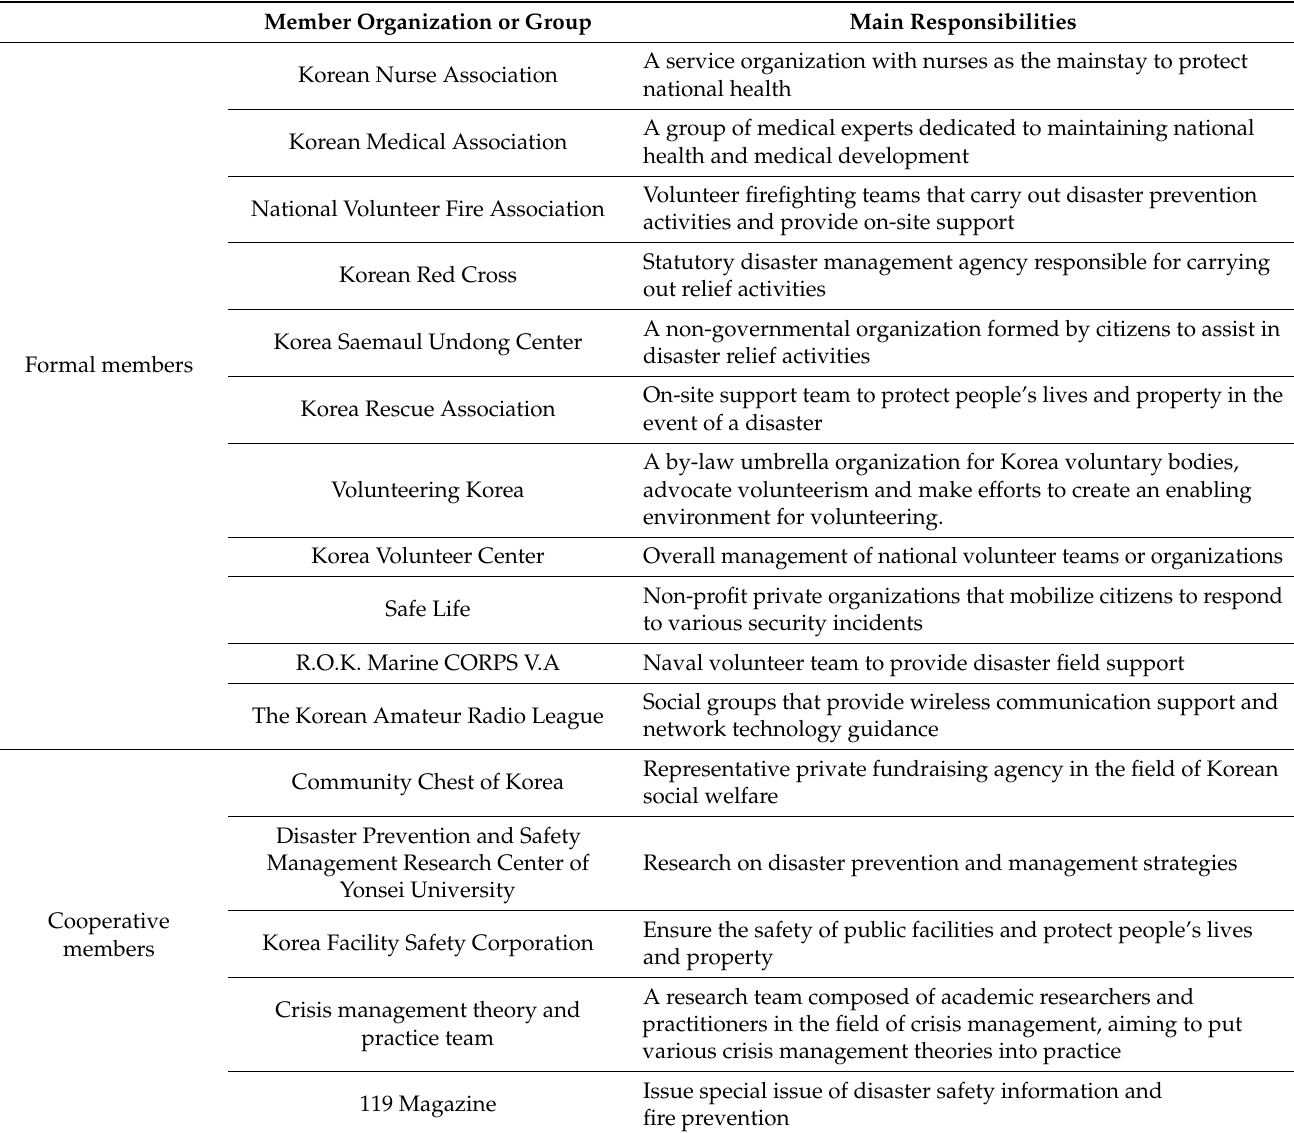
Table 3. Korea Disaster Prevention and Safety Network member organizations or groups and their main